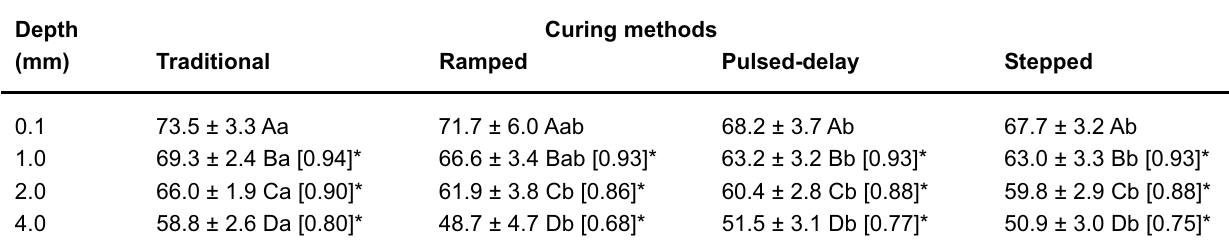
Different letters indicate statistically significant differences (p<0.05); uppercase letters compare the effect of depth of cure for each curing method (within columns) and lowercase letters compare curing methods for each depth of cure (within lanes). *[Microhardness ratio relative to the 0.1 mm